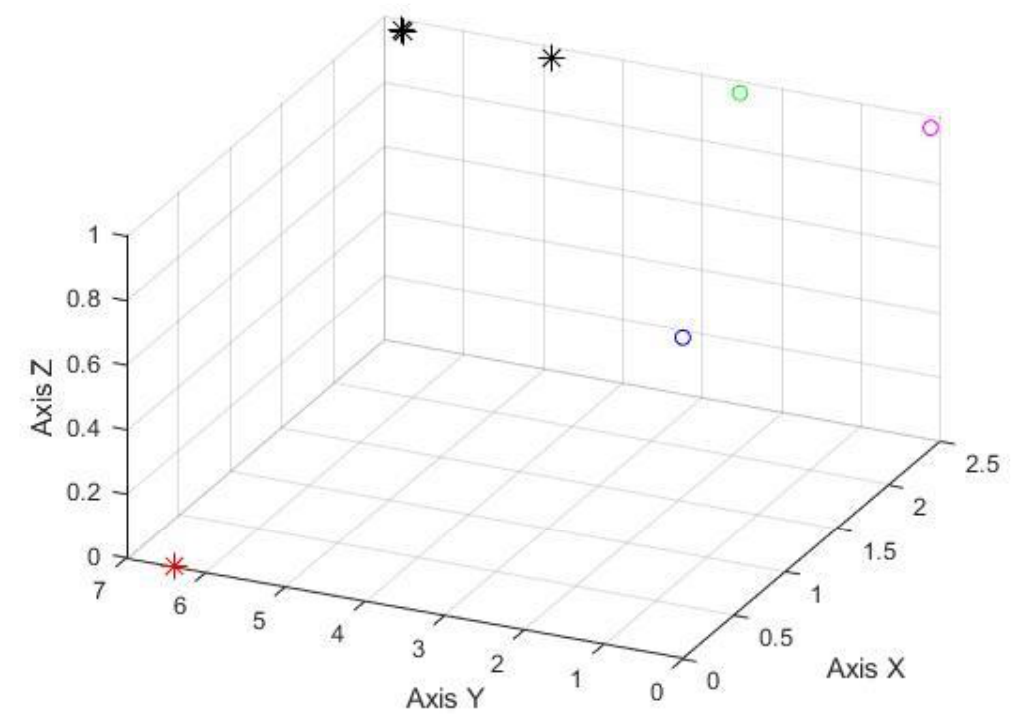
Figure 10. The experimental results of the shielded signal by tiles (unit in meter), the presentation of symbols is the same as Figure 8.